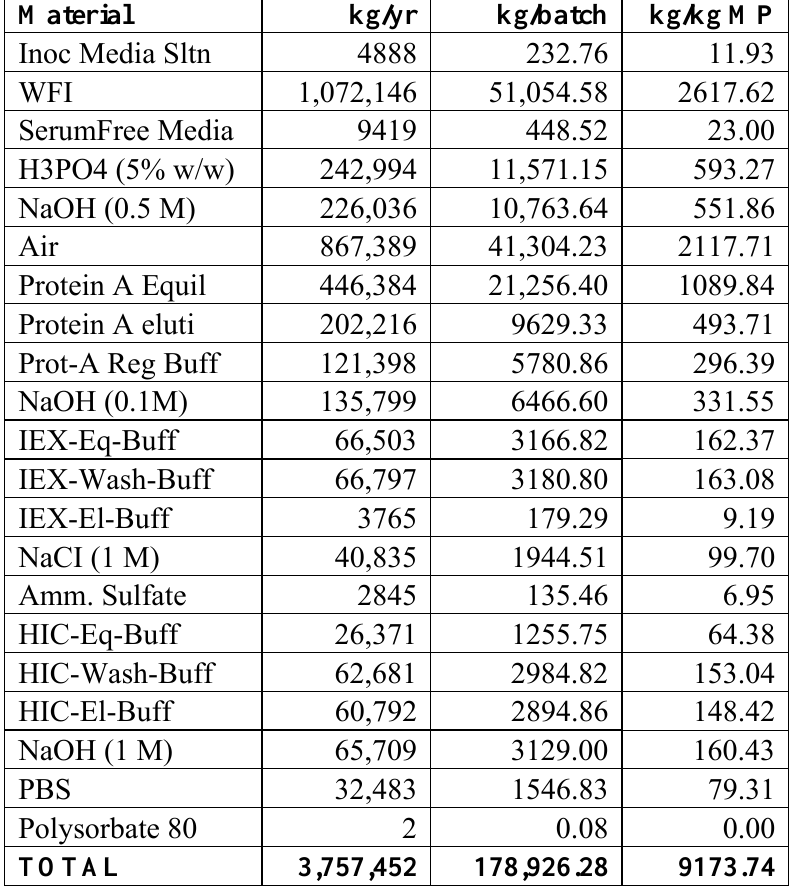
Table 1. Raw Material Requirements (MP = purified